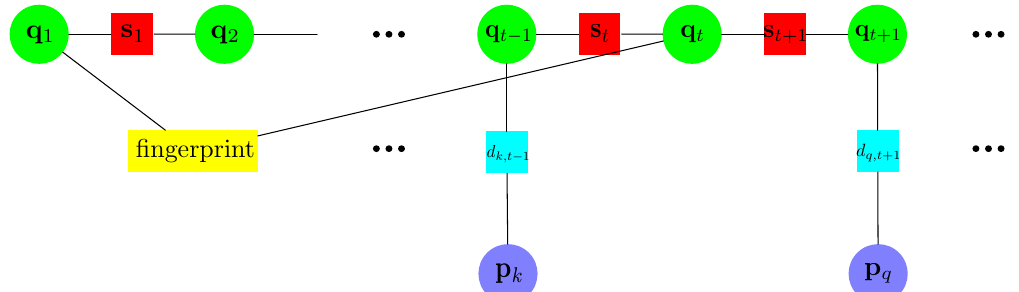
Figure 4. An illustration of the factor graph in BLE beacon implementation in our